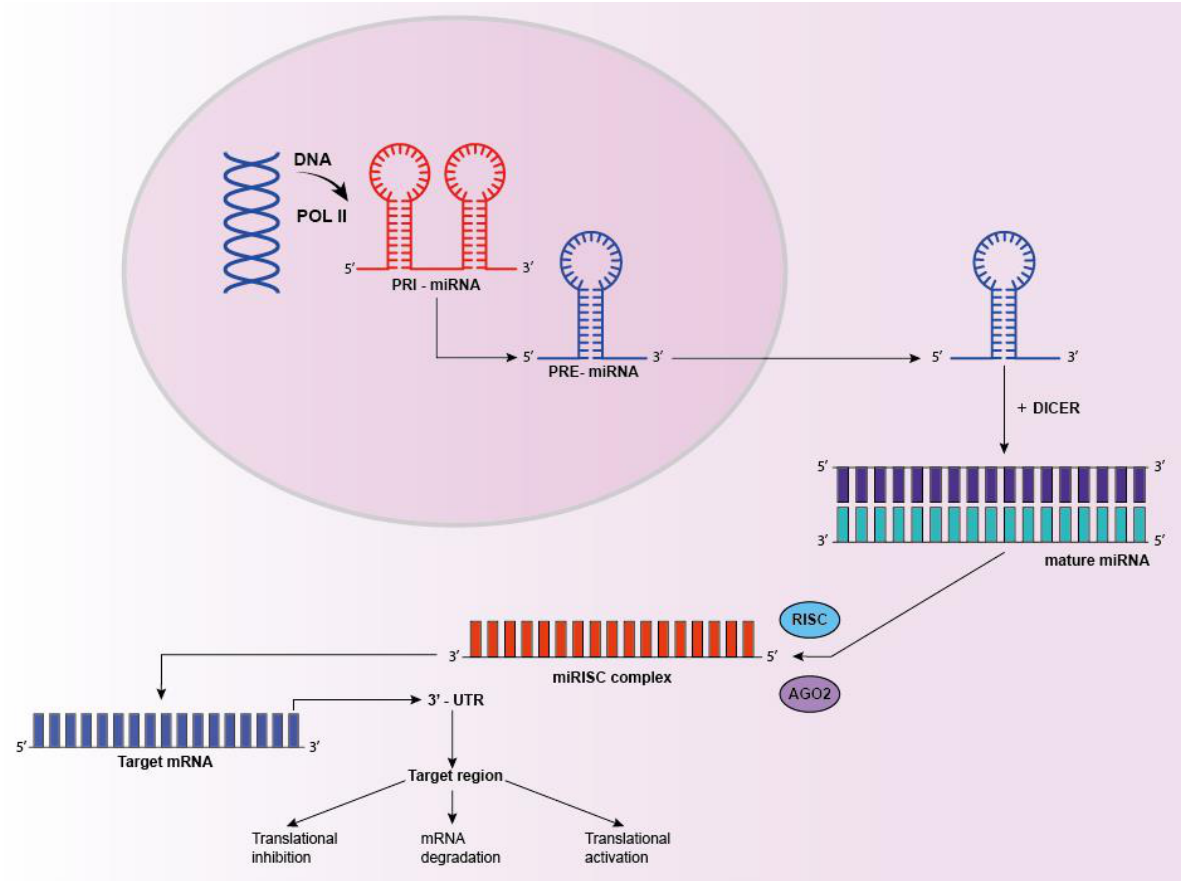
Figure 1. miRNA processing. miRNAs are transcribed in the nucleus as primary transcripts (pri-miRNAs), processed in pre-miRs, exported into the cytoplasm and subsequently processed by multi-protein complex DICER to generate mature duplex miRNAs. One strand of the mature miRNA (guide strand) is loaded into the miRISC complex to target mRNA by sequence complementarity. This interaction results in gene suppression by targeted mRNA degradation, translational repression or translational activation in processing bodies.